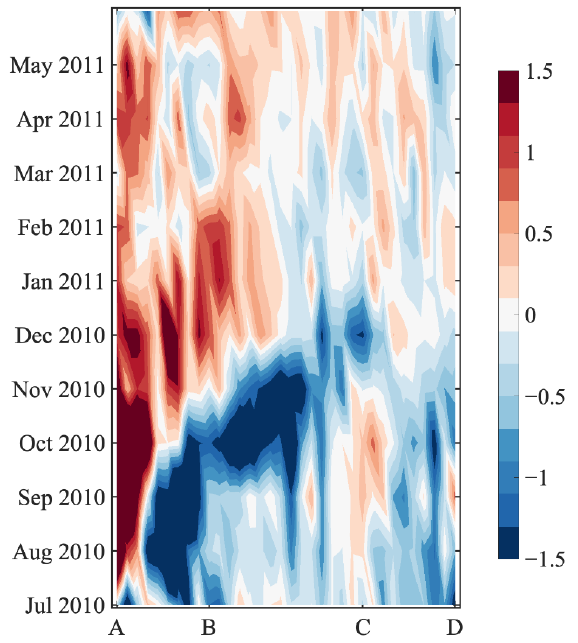
Figure 6. Hovmoller diagram of SMOS sea surface salinity anomaly of the dots along the east and west coasts of India in Figure 5g from July 2010 to May 2010 relative to the mean for the period 2010–2019.